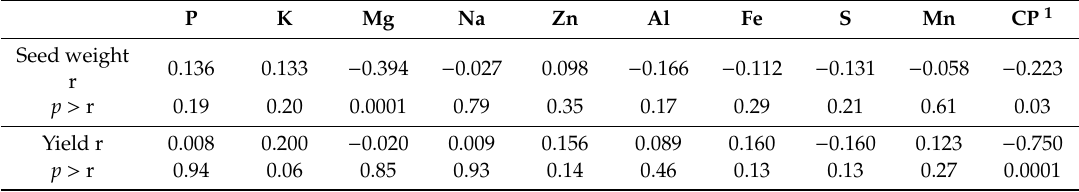
Table 5. Pearson correlation coe ffi cients for common bean seed weight and grain yield with seed concentrationsofphosphorus, potassium, magnesium, sodium, zinc, aluminum, iron, sulfur, manganese, and nitrogen across four locations and two years. P